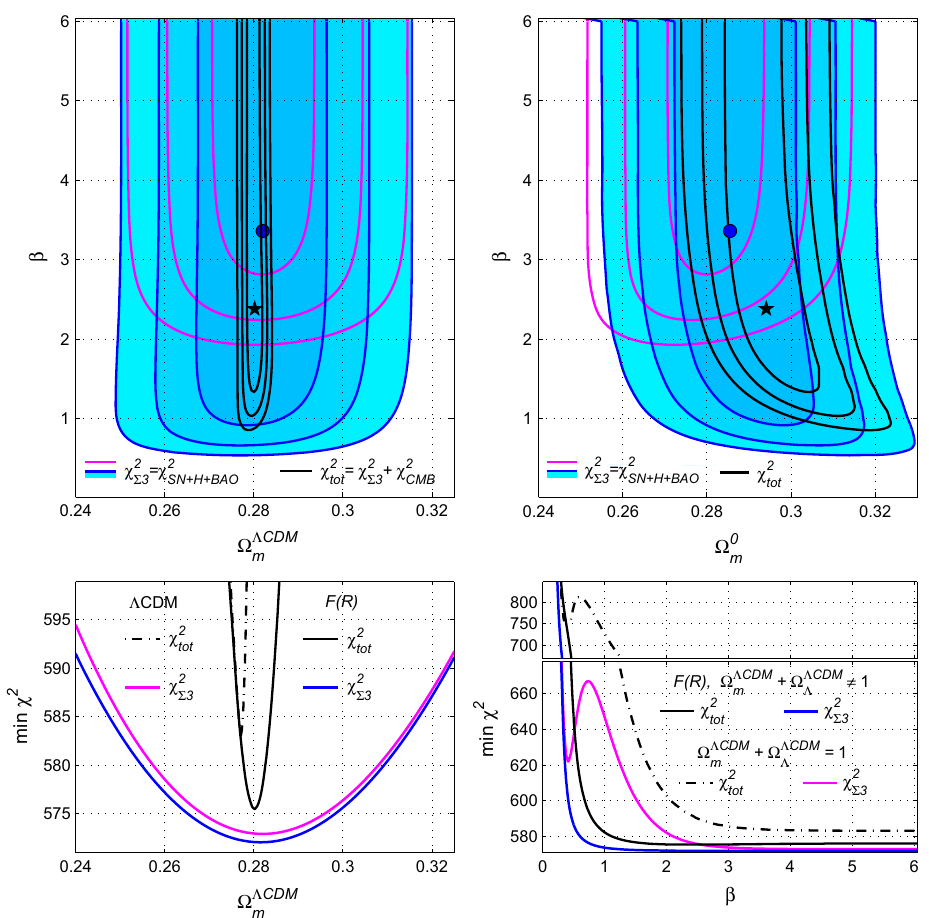
χ 2 (cid:17) 3 (solid blue lines and filled contours) are compared with the ones from Fig. 1 for χ 2 (cid:17) (magenta lines) and for χ 2 tot (thin black dash-dotted 3 lines)